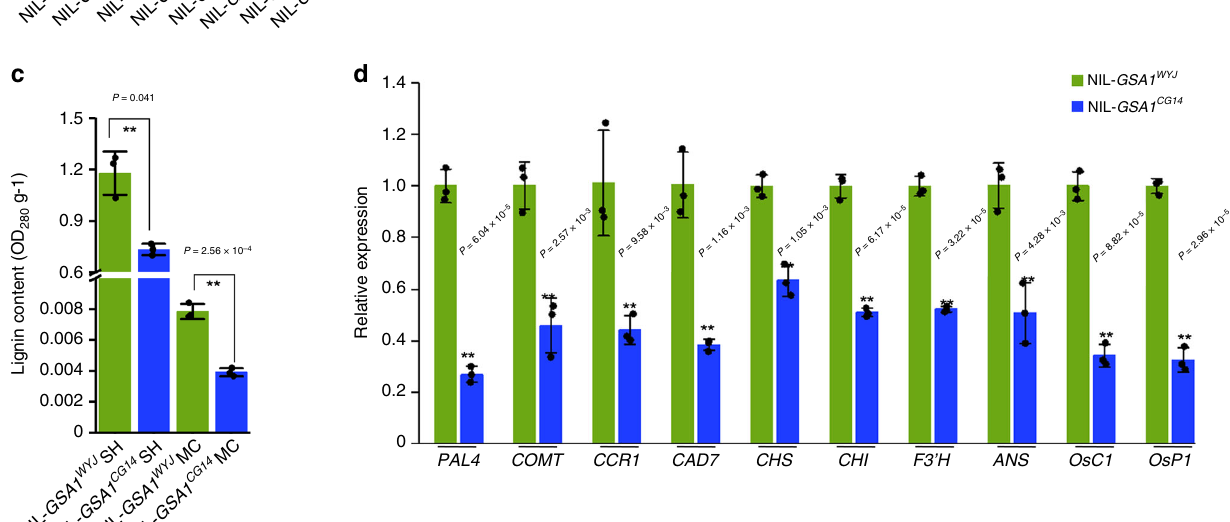
replicates). The ubiquitin gene was used for normalization. The values in b – d represent the mean ± s.d. * P < 0.05 and ** P < 0.01 indicate signi fi